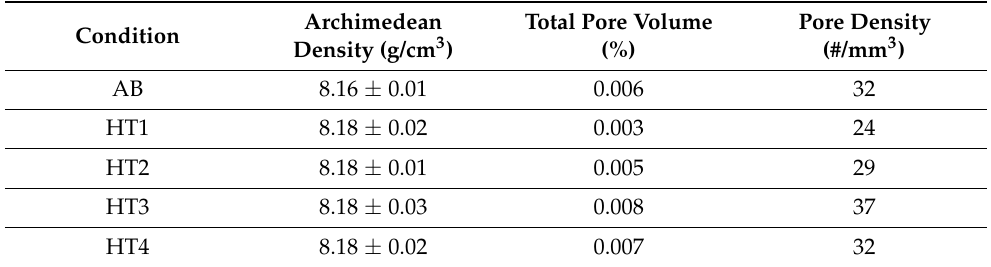
Table 4. Archimedean density, overall volume, and the number of detected voids from the µ -CT of IN718 specimens in each condition. Archimedean Condition Density (g/cm 3